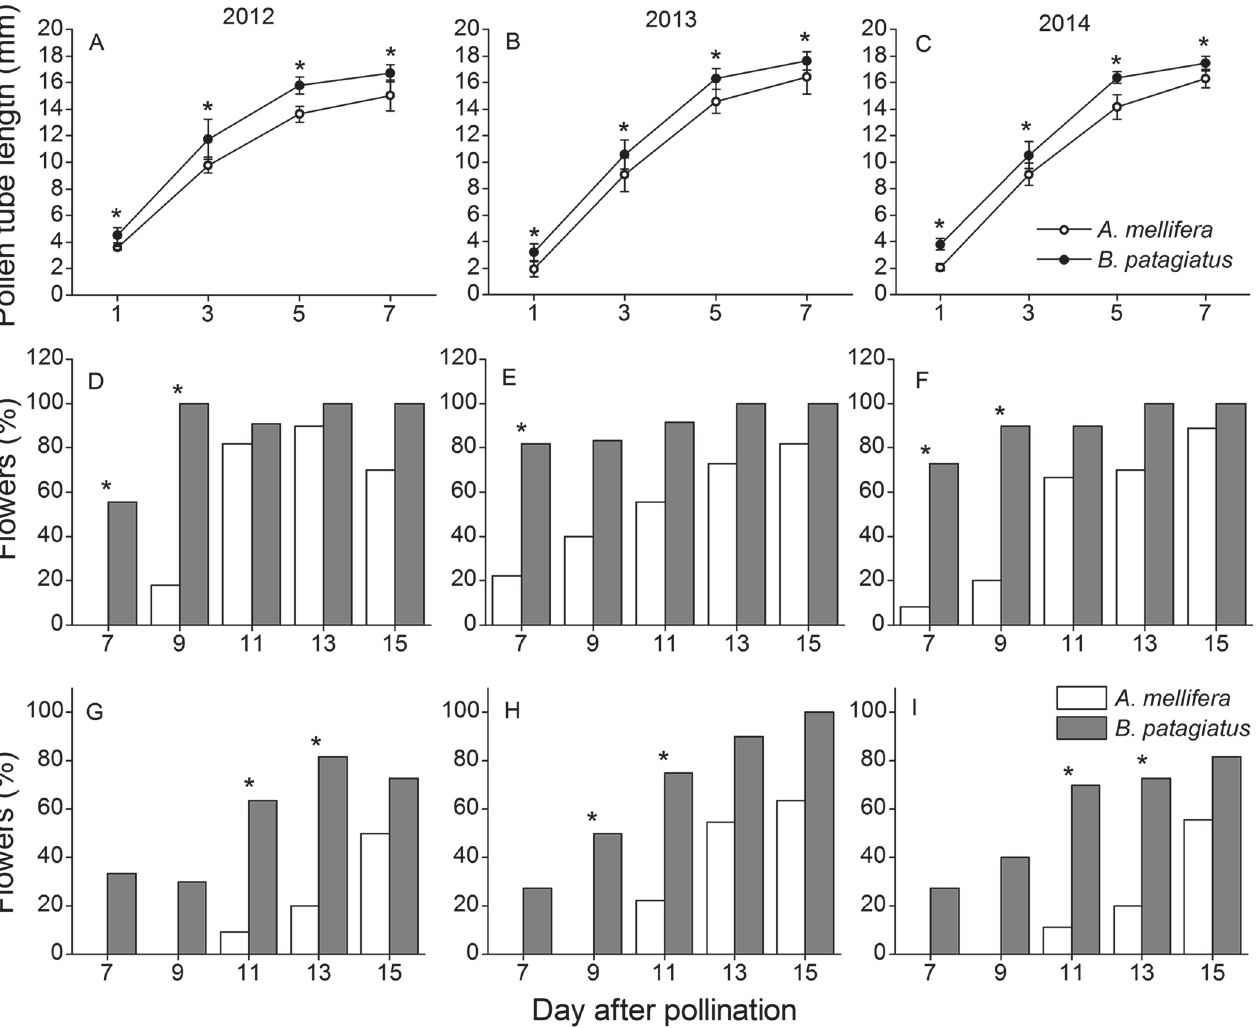
Fig 5. Pollen-tube performance in peach flowers pollinated by A . mellifera and B . patagiatus under greenhouse conditions. Lengths of pollen tubes (Mean ± SD) in the flowers after pollination at different times (1, 3, 5, 7 days) in year 2012 (A), 2013 (B), and 2014 (C). Percentages of investigated flowers with pollen tubes in the ovary after pollination at different times (7, 9, 11, 13, 15 days) in year 2012 (D), 2013 (E), and 2014 (F). Percentages of investigated flowers with fertilized ovules after pollination at different times (7, 9, 11, 13, 15 days) in year 2012 (G), 2013 (H), and 2014 (I). Within each year, flowers from all plots are combined here. Group t -test was used in graph A, B, C, and Fisher ’ s exact test was used in graph D, E, F, G, H, I. Single asterisks indicate significant difference at P <